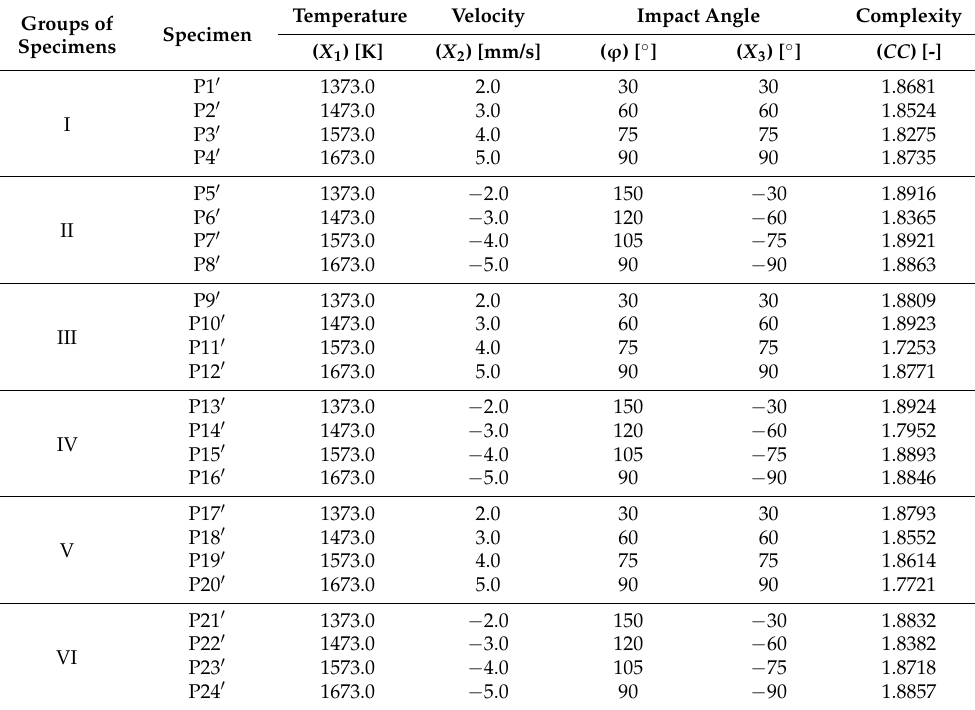
Table 1. Main parameters of GP. Parameter Values Size of organism population 500 Maximum number of generations 100 Reproduction probability 0.5 Crossover probability 0.6 Maximum permissible depth in the creation of the population 7 Maximum acceptable depth after the operation of crossover of two organisms 10 Smallest acceptable depth of organisms in generating new organisms 3 Tournament size used for the selection of organisms 6 Table 2. Process parameters and complexity index for the first set of RLH specimens. Groups of